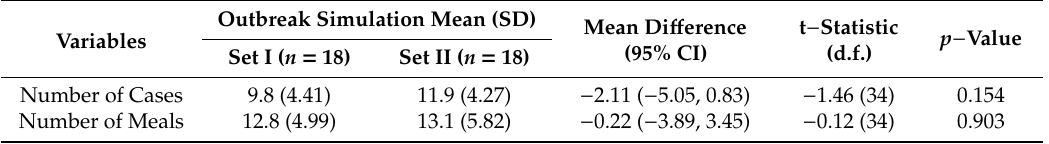
Table 2. Comparison of number of cases and number of meals between Set I and Set II of outbreak simulations.